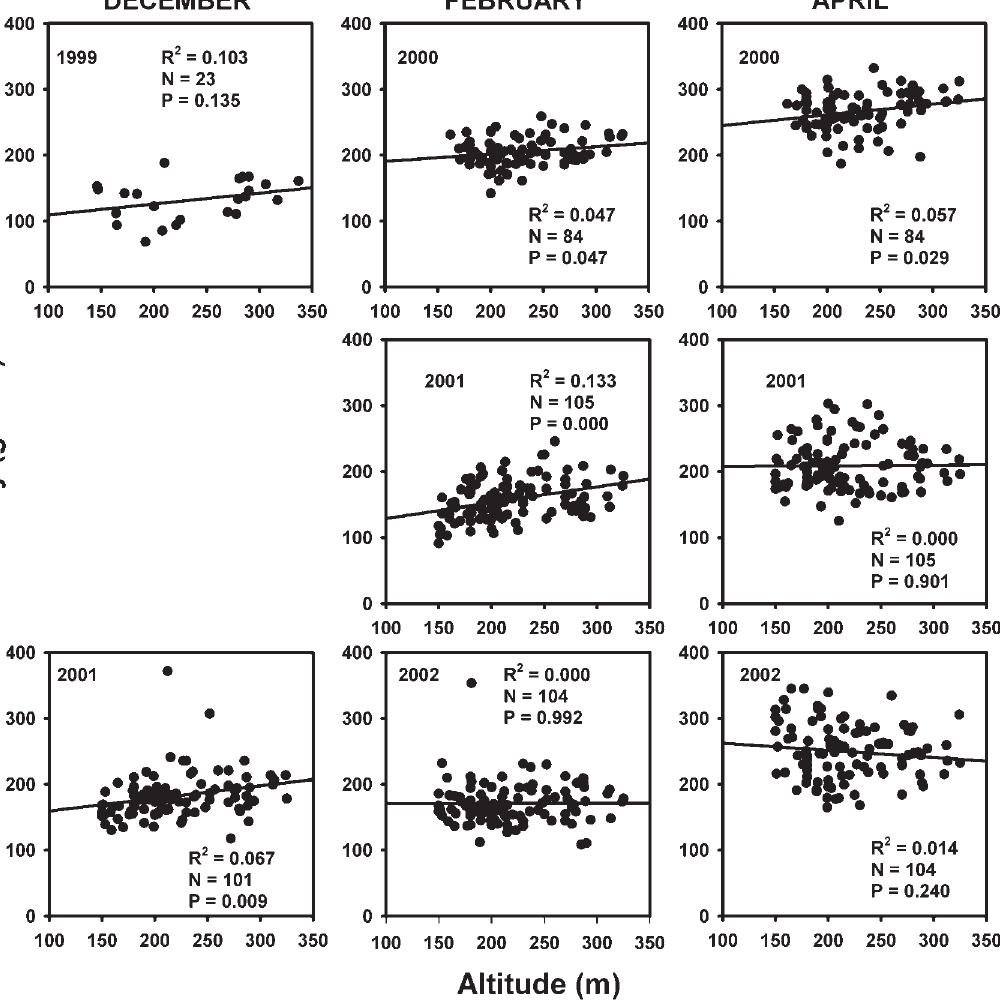
Fig. 6. Dependence of snow density (g/dm³) on altitude (m a.s.l.) in different months in the Ivalo reindeer herding district during winters 1999 - 2002. Simple regression